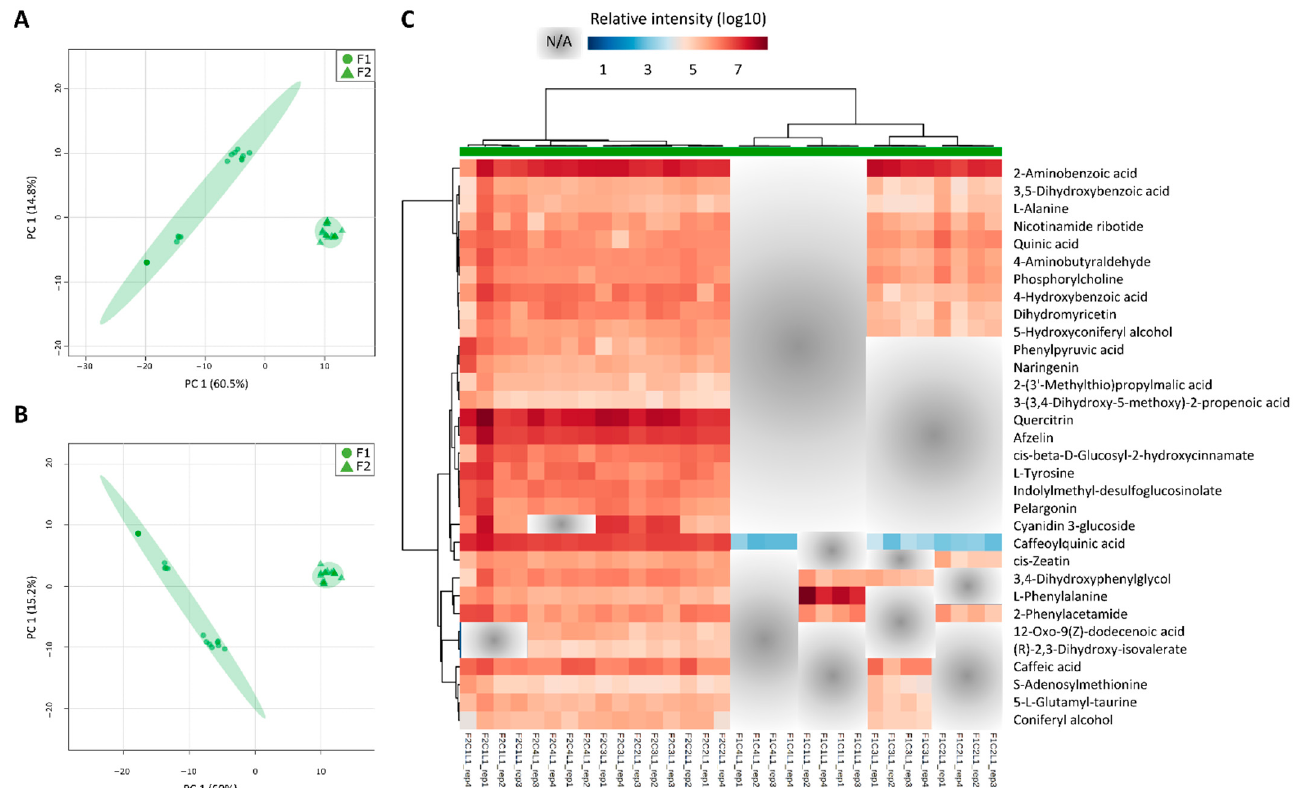
Figure 6. Leaf+1 metabolite profiles are different between fields 1 (F1) and 2 (F2). Discriminant models between field comparisons generated from the normalized and log10 transformed metabolomics data from the leaf +1 (L1) tissues, combining sampling points (C1, C2, C3, and C4) and experimental fields (F1 and F2). ( A ) PCA and ( B ) PLS-DA models for L1 (component 1 Q2 = 0.64317, R2 = 0.70436 and component 2 Q2 = 0.89506, R2 = 0.92523); ( C ) heatmap representation of the 32 main metabolites responsible for the separations (VIP scores ≥ 1.0 from PLS-DA analysis) and NA refers to non-detected metabolites.